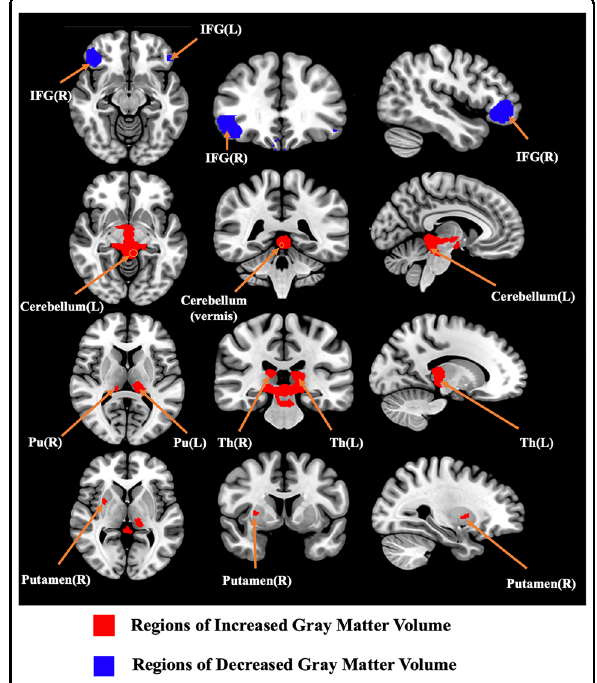
Fig. 2 Regions showing gray matter volume alterations in TS patients compared with healthy controls. Abbreviation: TS Tourette syndrome, L left, R right, IFG inferior frontal gyrus, Pu the pulvinar nucleus, Th